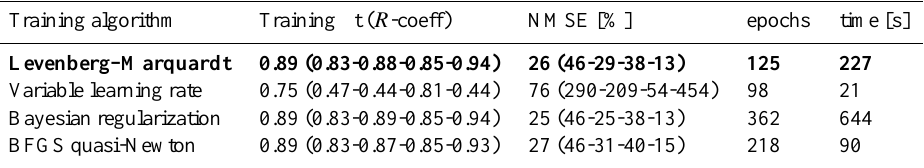
Table A6. Results of the sensitivity analysis on PhytoANN’s type of training algorithm. Metrics are correlation coefficient and normalized mean-squared error on log-transformed data, number of training iterations (epochs) and training time. Presented statistics are ensemble means from five runs under same configuration but different sample division and weight and bias initialization. Values in parentheses represent statistics for diatoms, coccolithophores, cyanobacteria and chlorophytes,